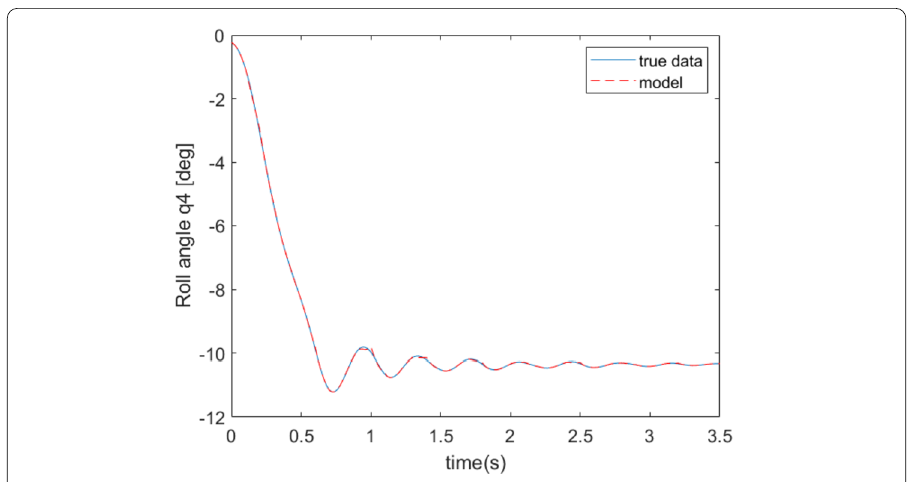
Figure 16 Model match between the identified nonlinear model against the measured roll angle response